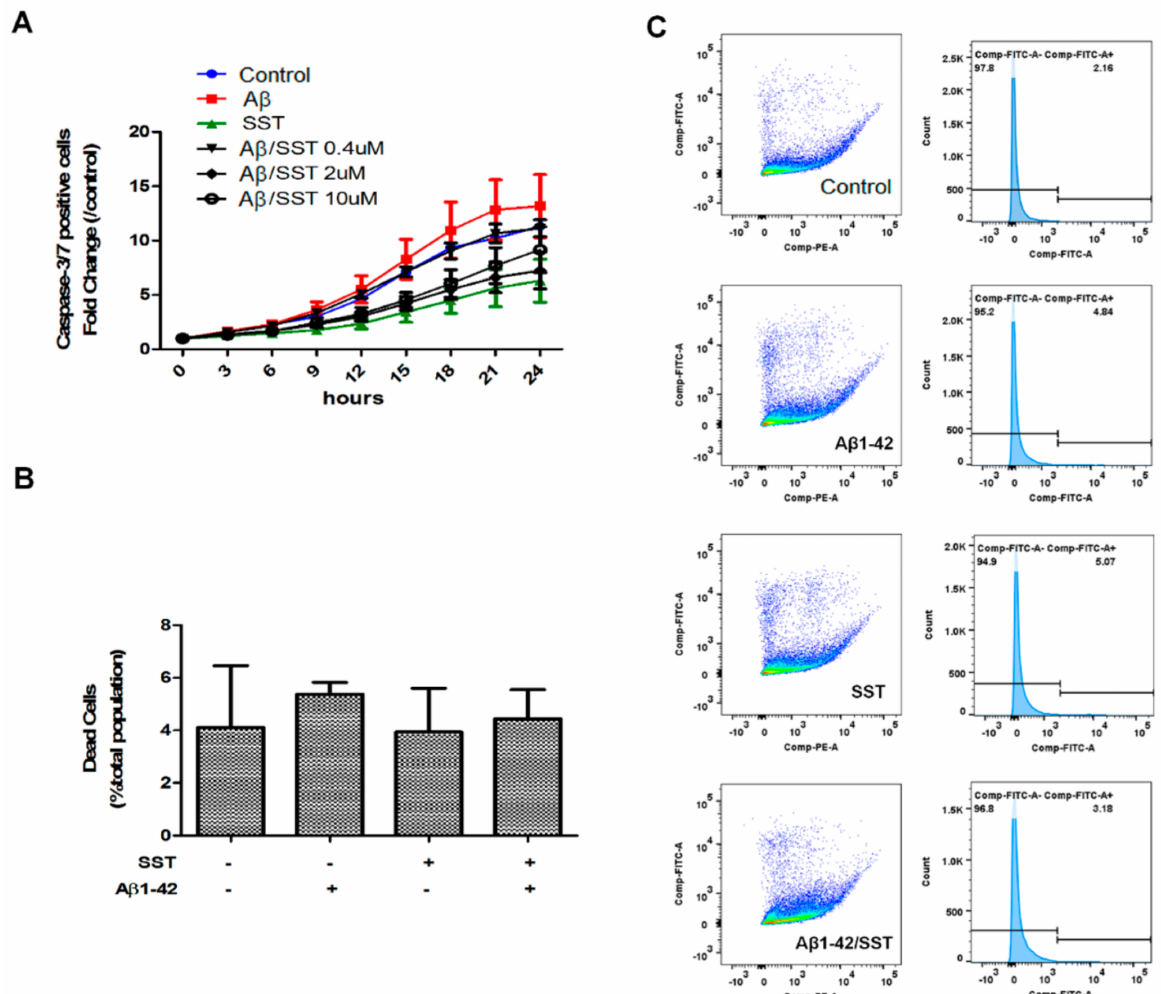
Figure 2. SST inhibits the A β -induced activation of apoptosis. ( A ) Apoptosis induction was assessed by measuring caspase-3/7 activity. Cells treated with A β (5 µ M) alone displayed an elevation of caspase-3/7 activity, while cells treated with SST alone (10 µ M) exhibited the lowest caspase-3/7 activity. Co-treatment of A β 1-42 (5 µ M) and SST resulted in reduced caspase-3/7 activity compared to the cells treated with A β 1-42 alone. Data are shown as a fold-change against 0 h time point. ( B ) Cell viability assessed by a live/dead assay using metabolic activity and cell permeability as an index following treatment with A β (5 µ M) and SST (10 µ M) alone or in combination ( C ). Representative FACS data of C 12 -resazurin and SYTOX fluorescence intensity (dot plot) and FITC intensity distribution (histogram) displaying the distribution of cells based on viability. The cells were treated with A β (5 µ M) and SST (10 µ M) alone or in combination. The data represent the mean ± SD of three independent